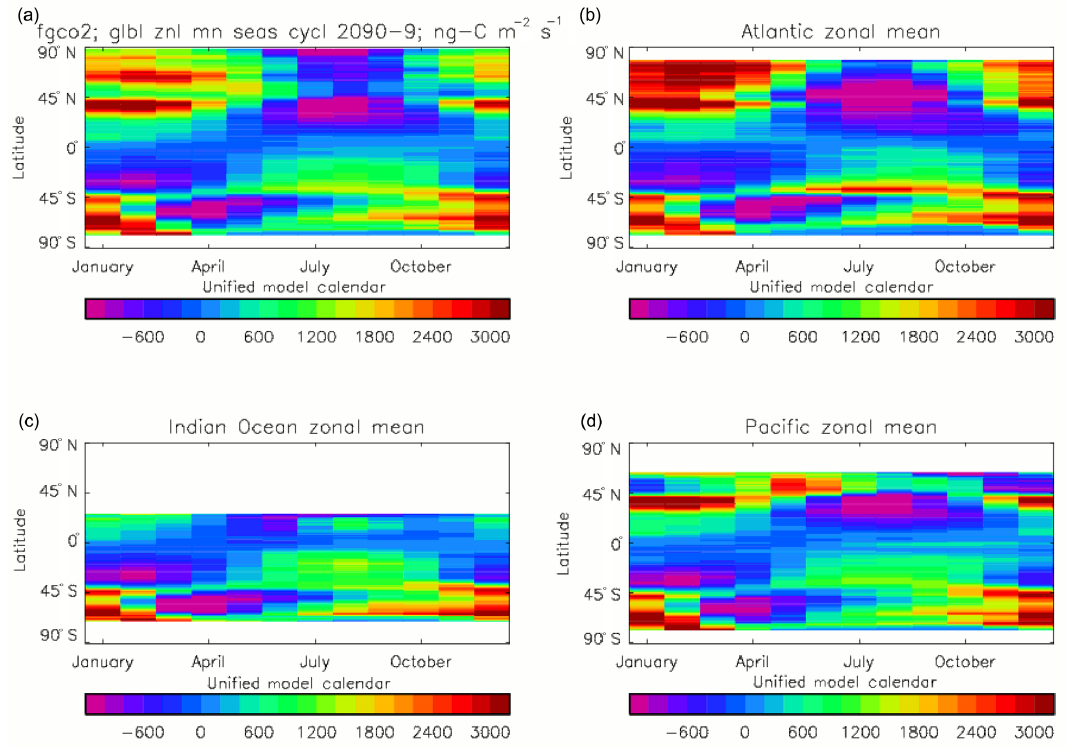
Figure 42. The seasonal cycle (monthly means) of the total air-to-sea CO 2 flux (ngCm − 2 s − 1 ) averaged over the model years 2090–2099. Zonal mean of (a) global ocean, (b) Atlantic Ocean basin, (c) Indian Ocean basin, (d) Pacific Ocean